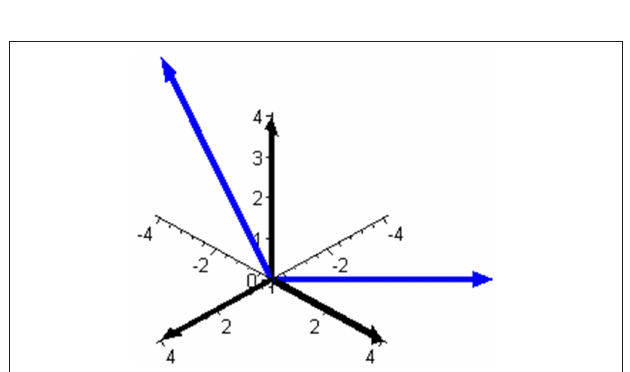
FIGURE 2 | Illustration of the one-dimensional subspace W (red) and the complementary, orthogonal two-dimensional subspace V (gray) in the mixture of butene isomers.